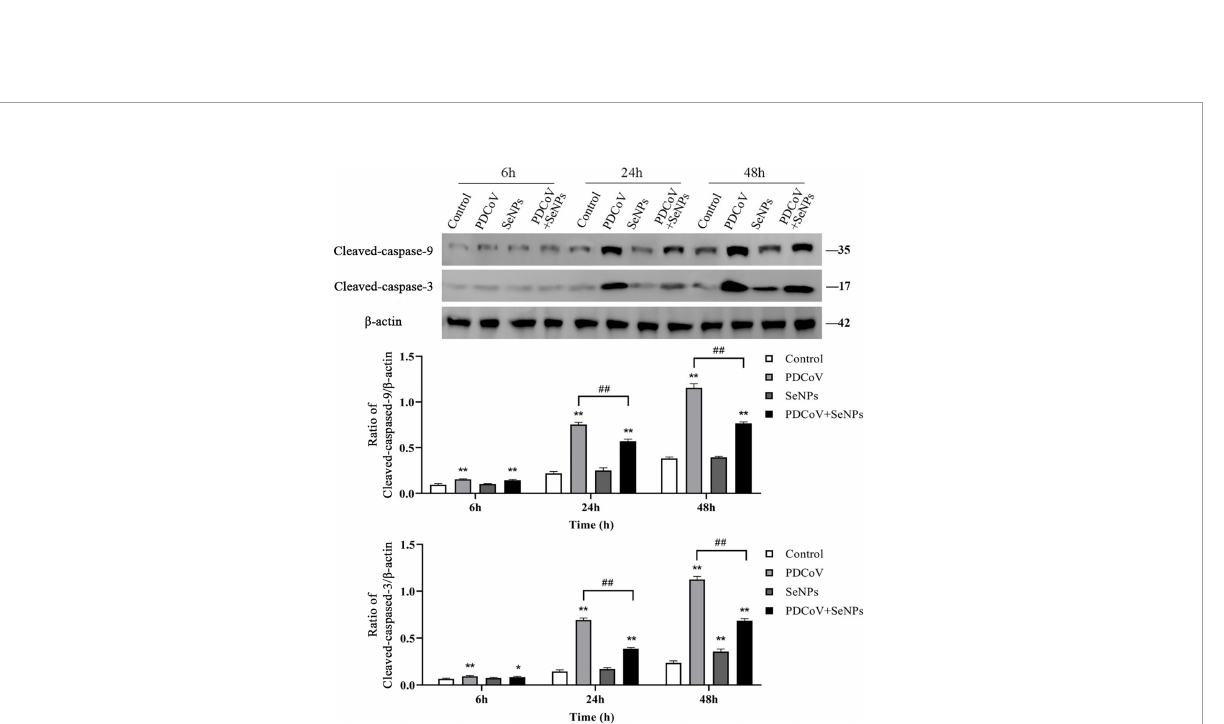
FIGURE 10 Effect of SeNPs on apoptosis-related proteins of ST cells infected with PDCoV. Top is immunoblot bands of Cleaved-caspase-3 and Cleaved- caspase-9 in each treatment group at 6, 24, and 48 h. At the bottom is a histogram after analyzing and calculating the ratio of grayscale values of the Cleaved-caspase-3 and Cleaved-caspase-9. * indicates that the difference is signi fi cant compared with the control group (P < 0.05), ** indicates that the difference is extremely signi fi cant compared with the control group (P < 0.01); ## indicates that there is a signi fi cant difference between the PDCoV group and the PDCoV + SeNPs group (P < 0.01), and there is no signi fi cant difference (P > 0.05) in the unlabeled expression, n=3.